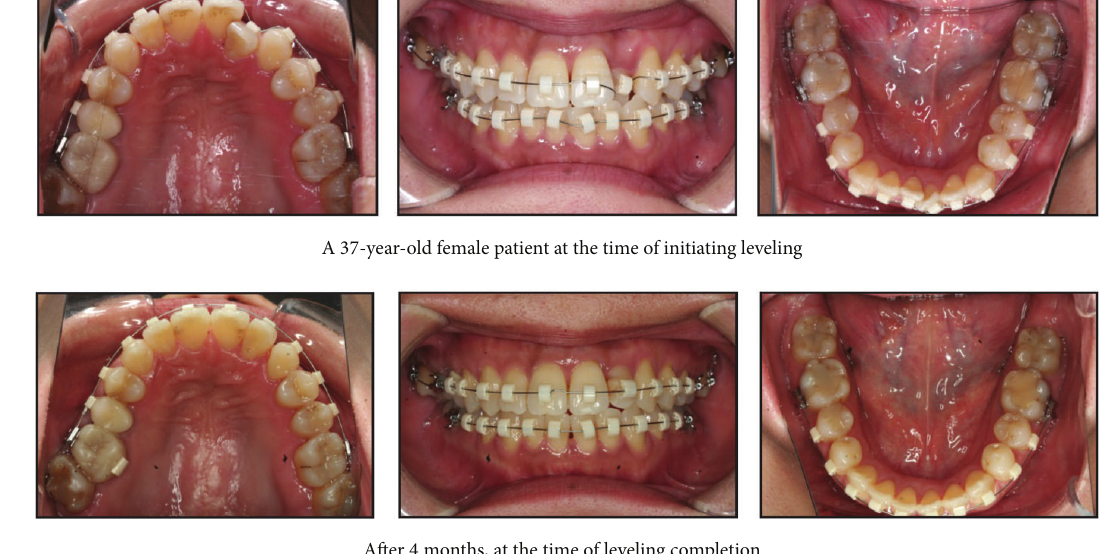
Figure 6: Intraoral photographs before and after leveling completion in the M